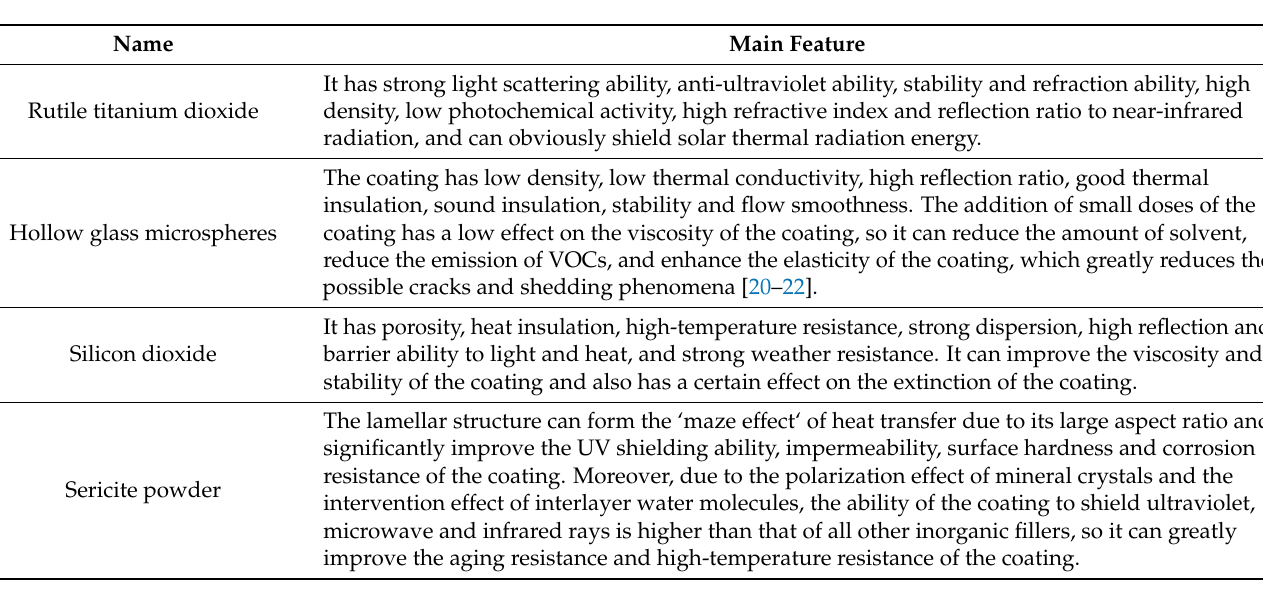
Table 4. Main characteristics of four functional